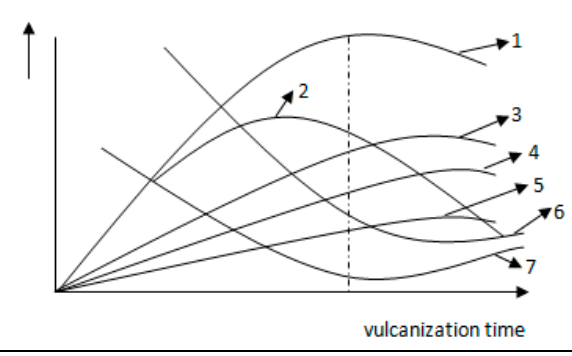
Figure 3. Rubber mass performance for different times of the vulcanization reaction process [25]. 1, Tensile strength; 2, tear strength; 3, resilience; 4, hardness; 5, 300% stretching strength; 6, elongation; 7, permanent deformation.